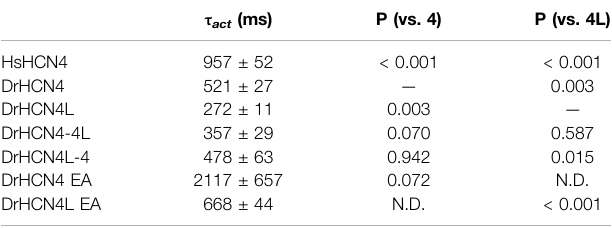
TABLE 1 | Activation time constants ( τ act ) and p -values for the HCN4 channels. N.D.; not determined.